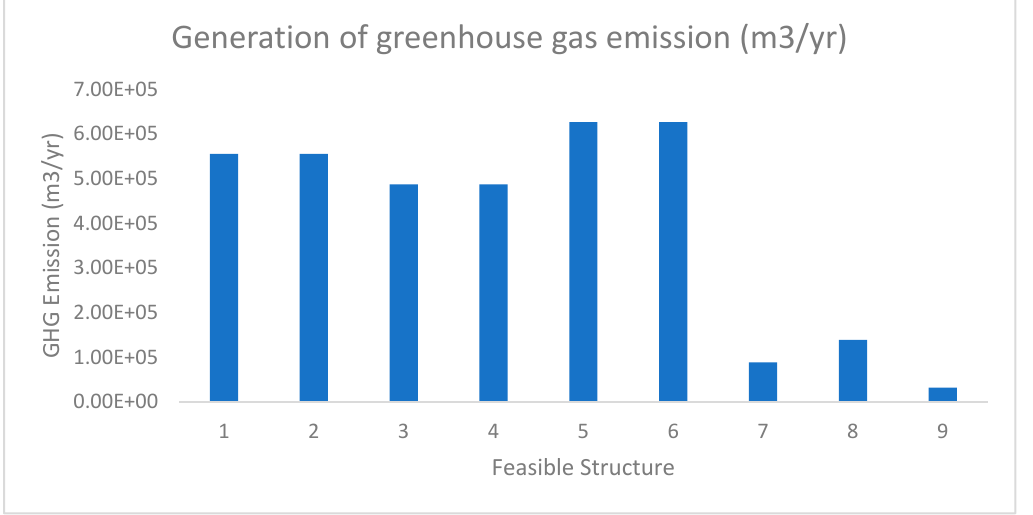
Figure 7. Generation of greenhouse gas for each feasible structure.